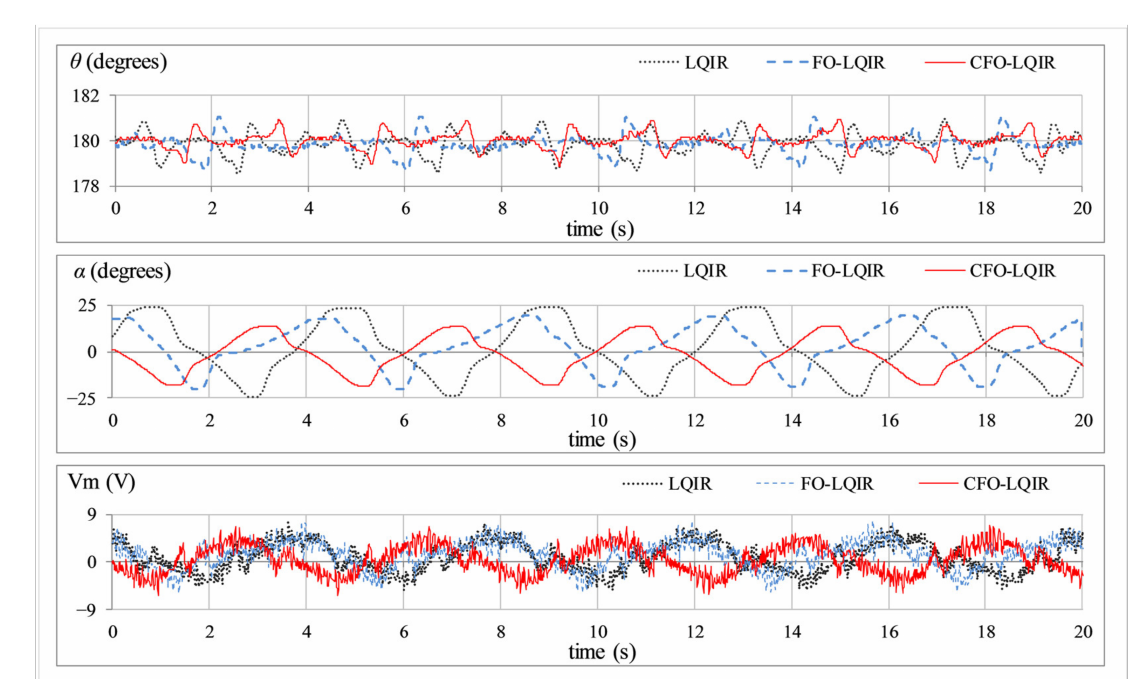
Figure 4. SRIP’s response under normal conditions.